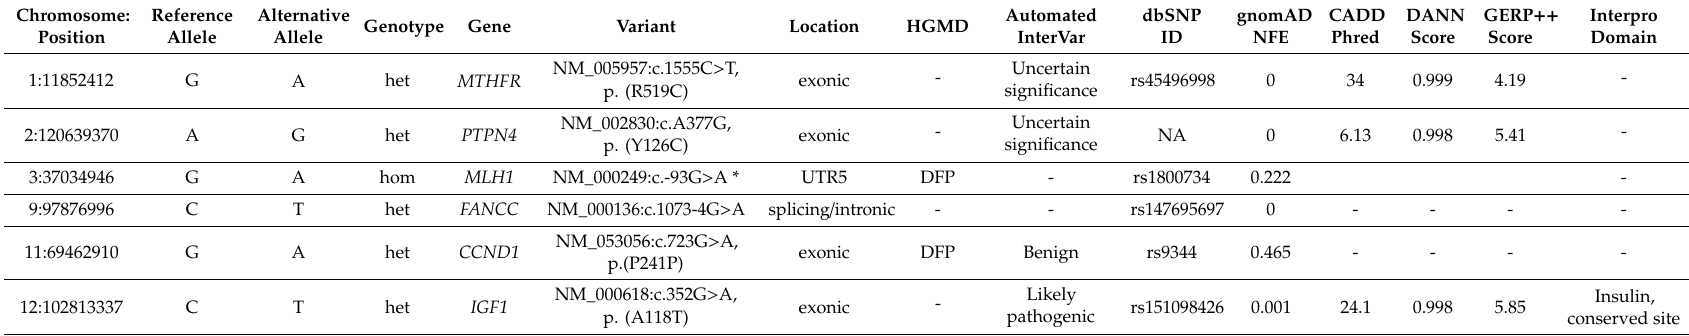
Table 1. Germline candidate variants. Germline changes found by exome analysis that could potentially have a modifying e ff ect in the LS environment and could therefore a ff ect age of cancer